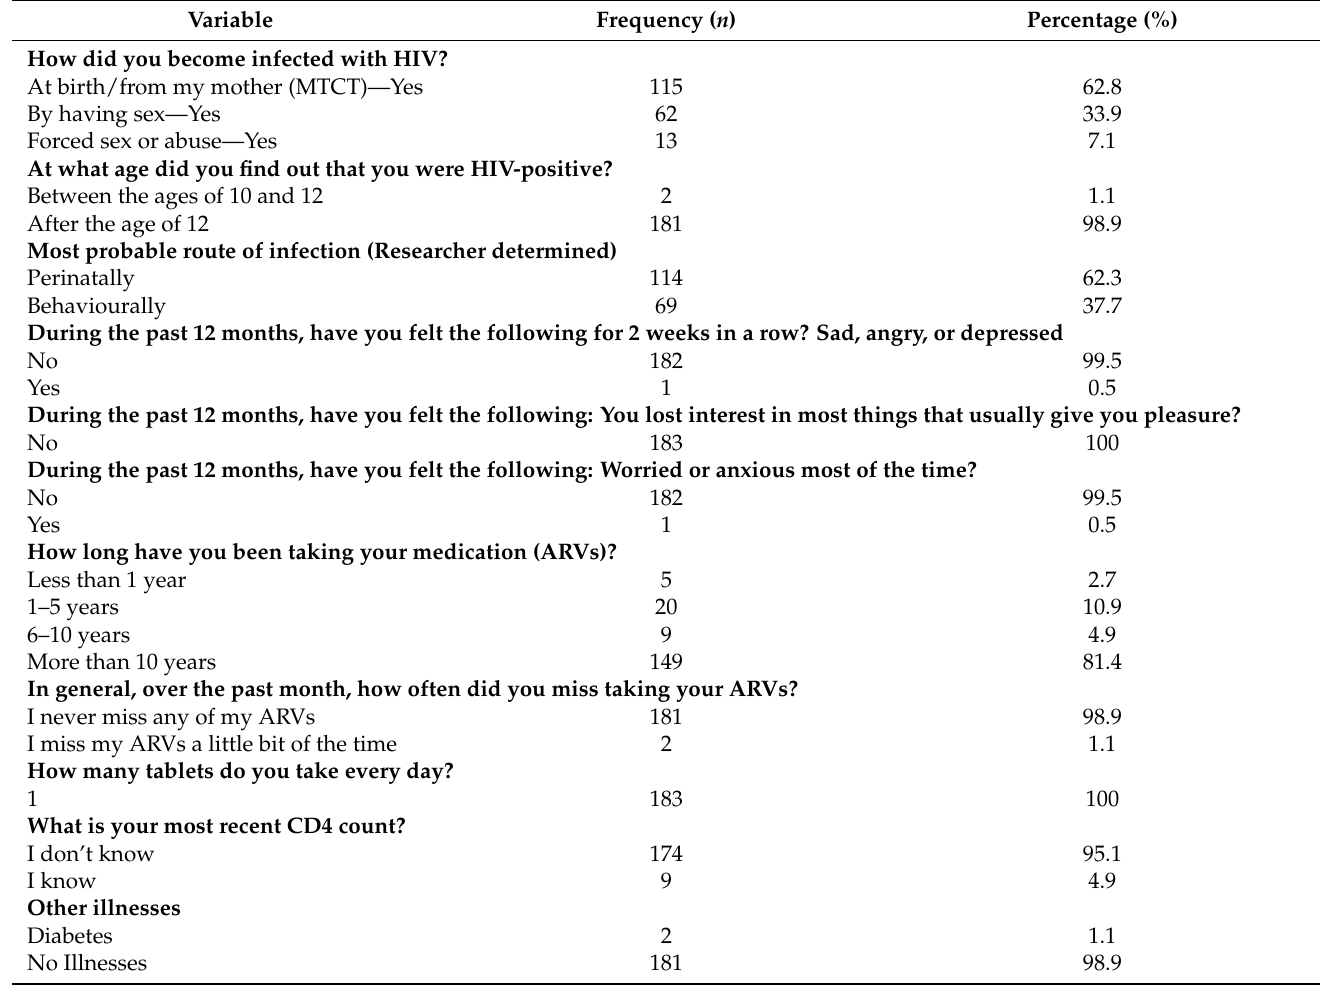
Table 2. Health and treatment information.